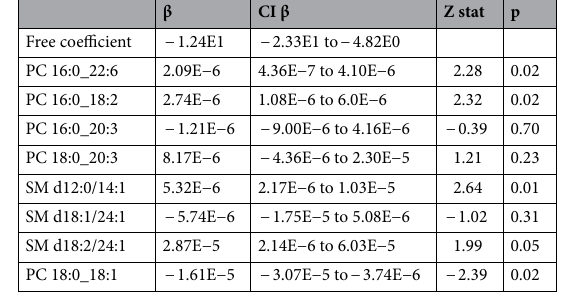
Table 4. Coefficients for the logistic regression of diagnostic model “control group/RUF group”.